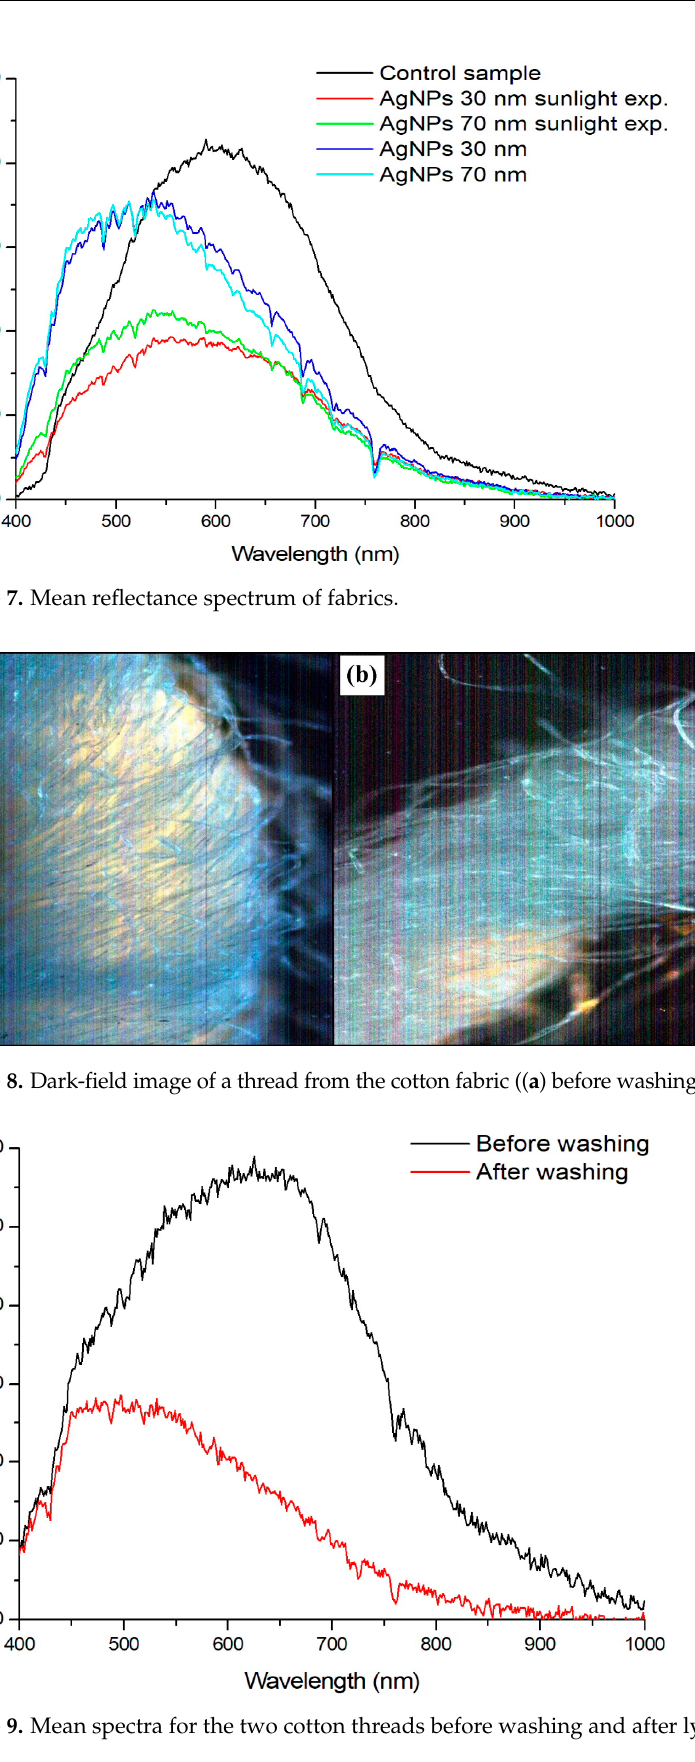
Figure 9. Mean spectra for the two cotton threads before washing and after lye washing .